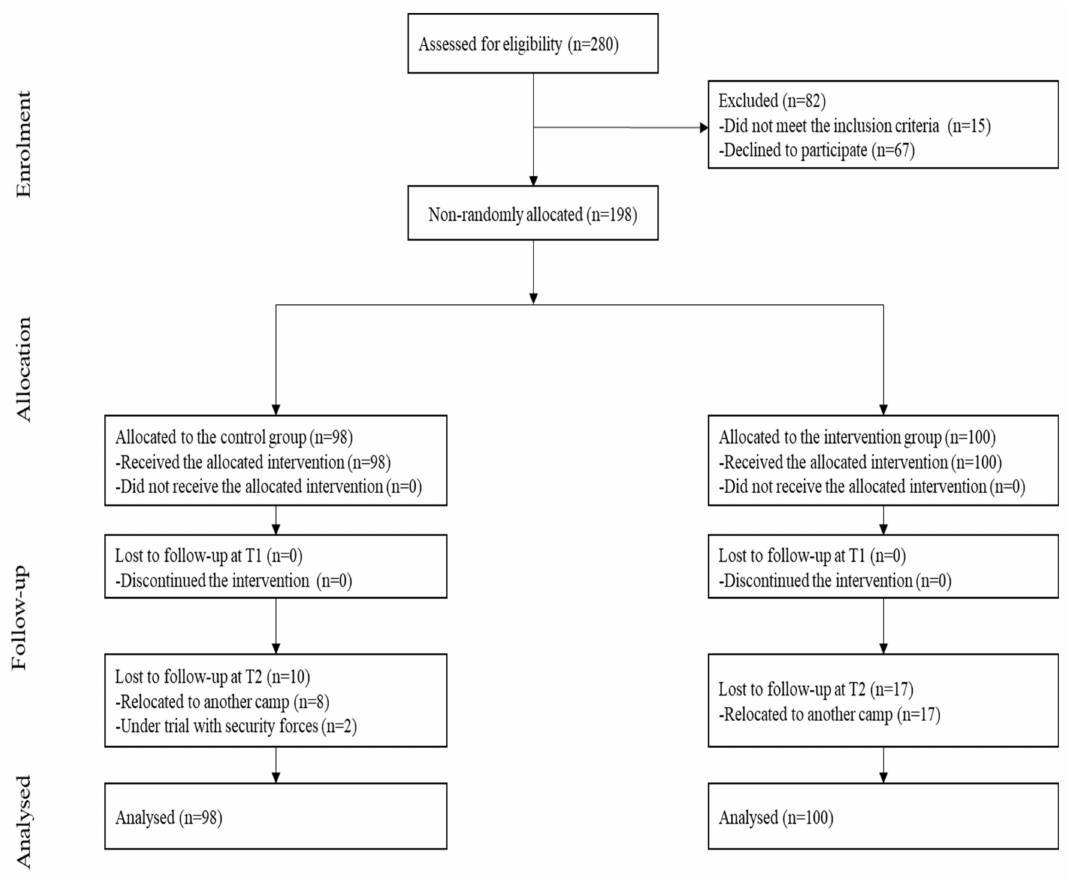
Figure 1. Flowchart. Table 3. Demographic and clinical